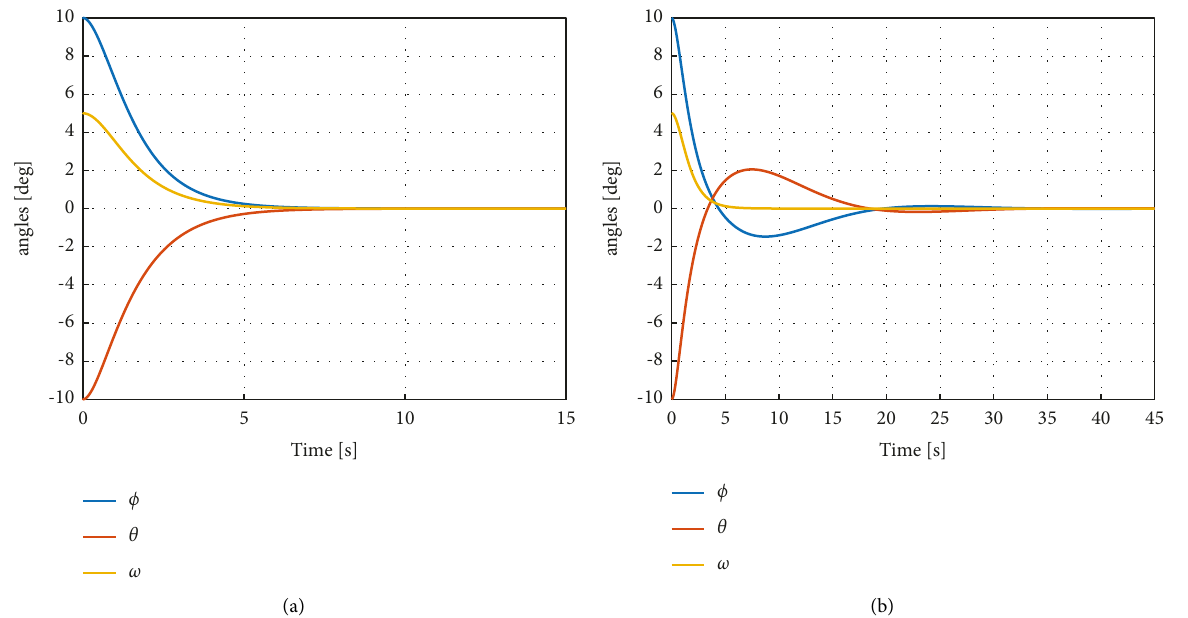
Figure 18: The angles ϕ , θ , and ψ stabilize to zero after 35 s; the ϕ and θ states experience overshoots before stabilizing to zero.